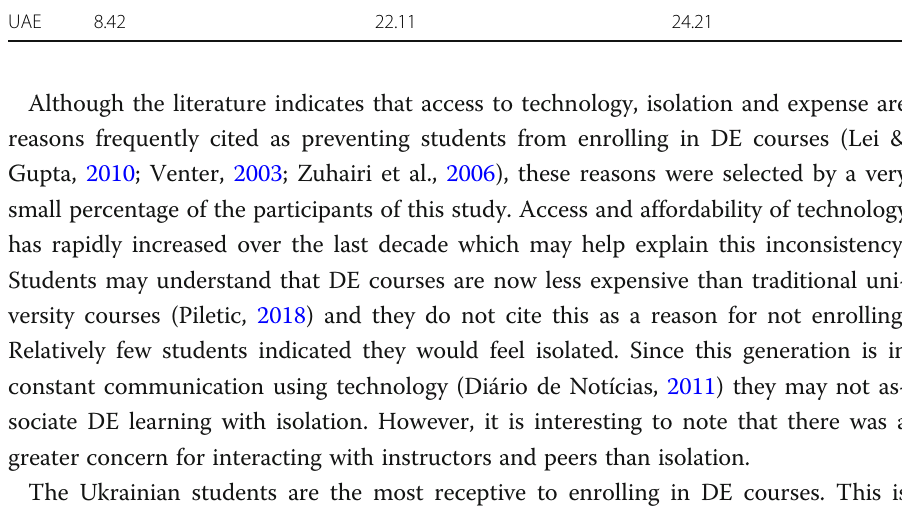
Table 11 Types of distance education interested in trying (More than one could be chosen) Country Synchronous (Students and instructor meet at the same time online)